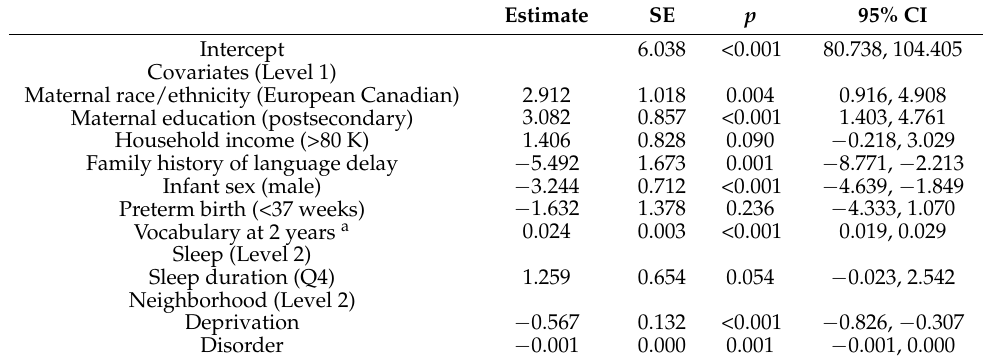
Table 3. Multilevel model results for neighborhood predictors of language at 5